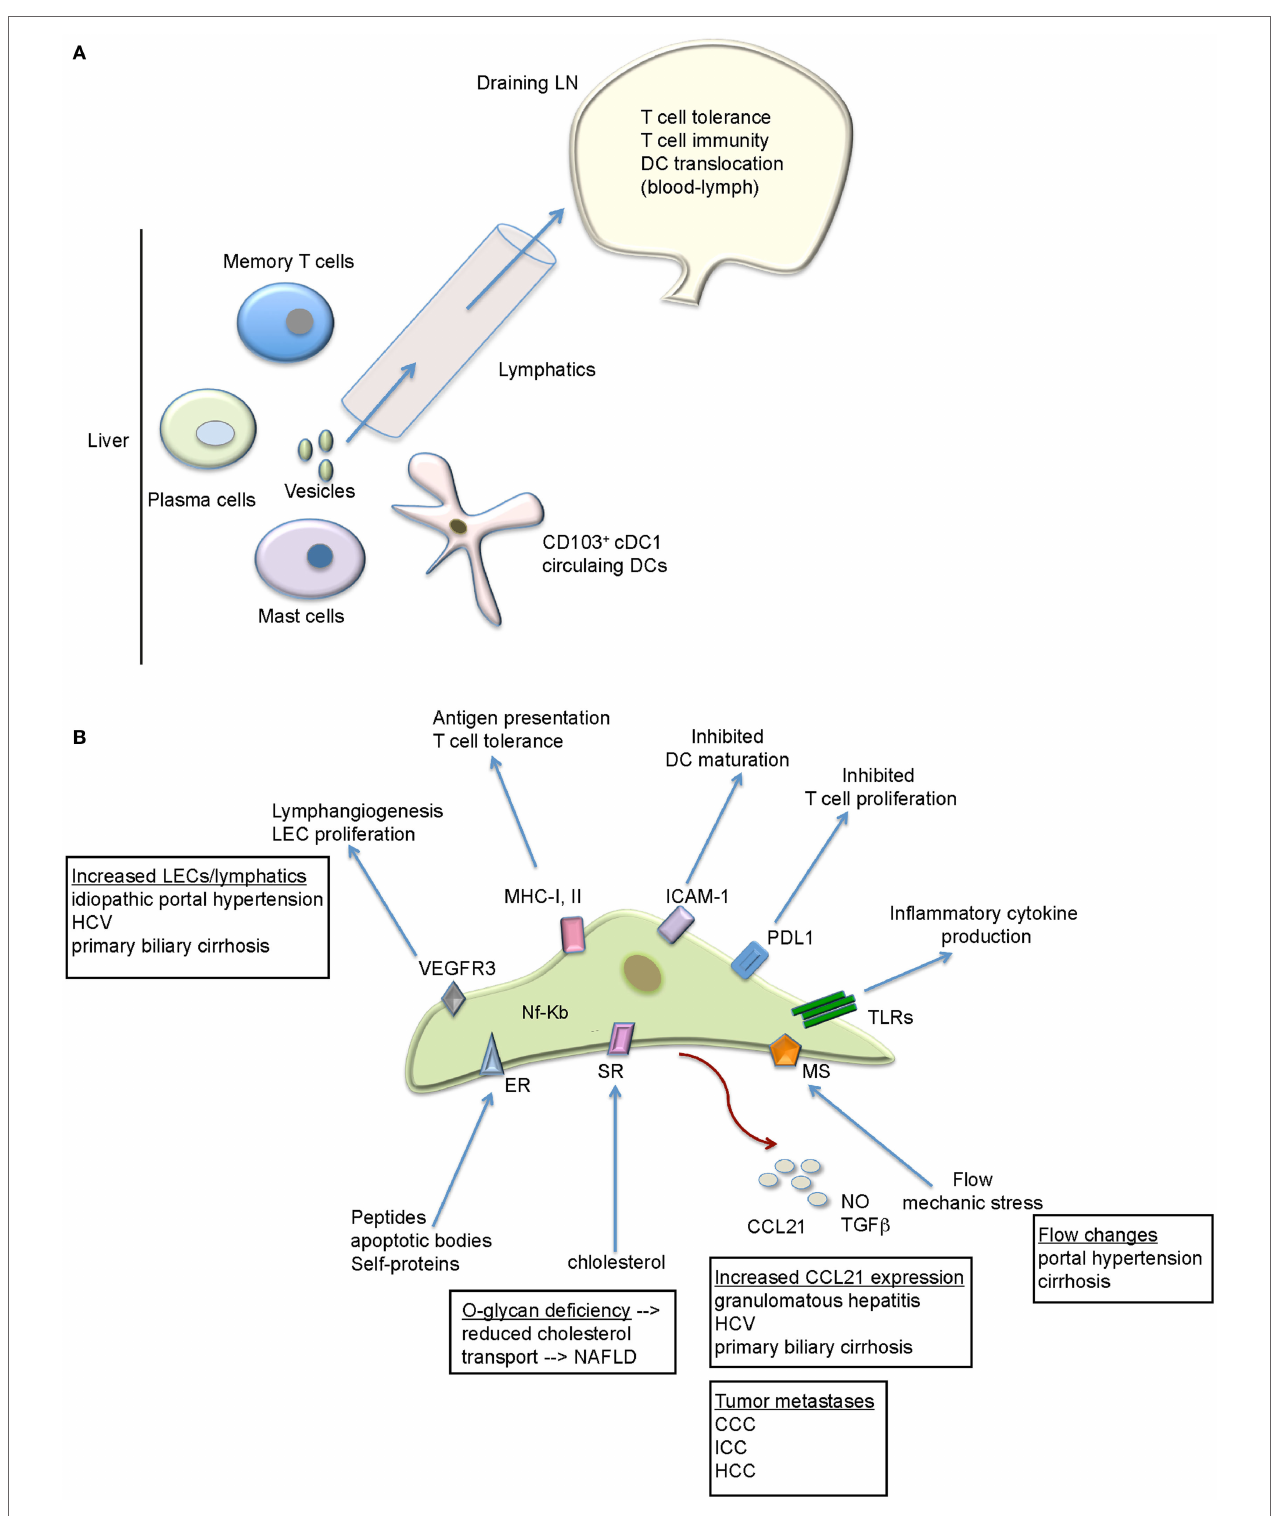
FiGURe 1 | The functional role of the lymphatics within the liver . (A) Besides fluid handling, the hepatic lymphatics transport various immune cell types, proteins, and vesicles to the draining LN. The LN provides the environment where not only tolerogenic but also immunogenic T cell response can arise that target liver pathogens/antigens. (B) LECs exhibit a variety of immunoregulatory functions that might be relevant for liver diseases. Future studies are necessary to evaluate all of these possibilities. Liver diseases with lymphatic/LEC alterations are depicted. CCC, colorectal carcinoma; ER, endocytic receptor; HCC, hepatocellular carcinoma; ICC, intrahepatic cholangiocytes carcinoma; MS, mechanosensors; SR, scavenger receptors, TLRs, toll-like